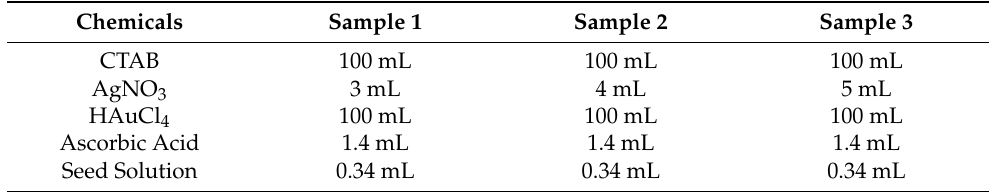
Table 1. Chemicals and their amount used for preparation of